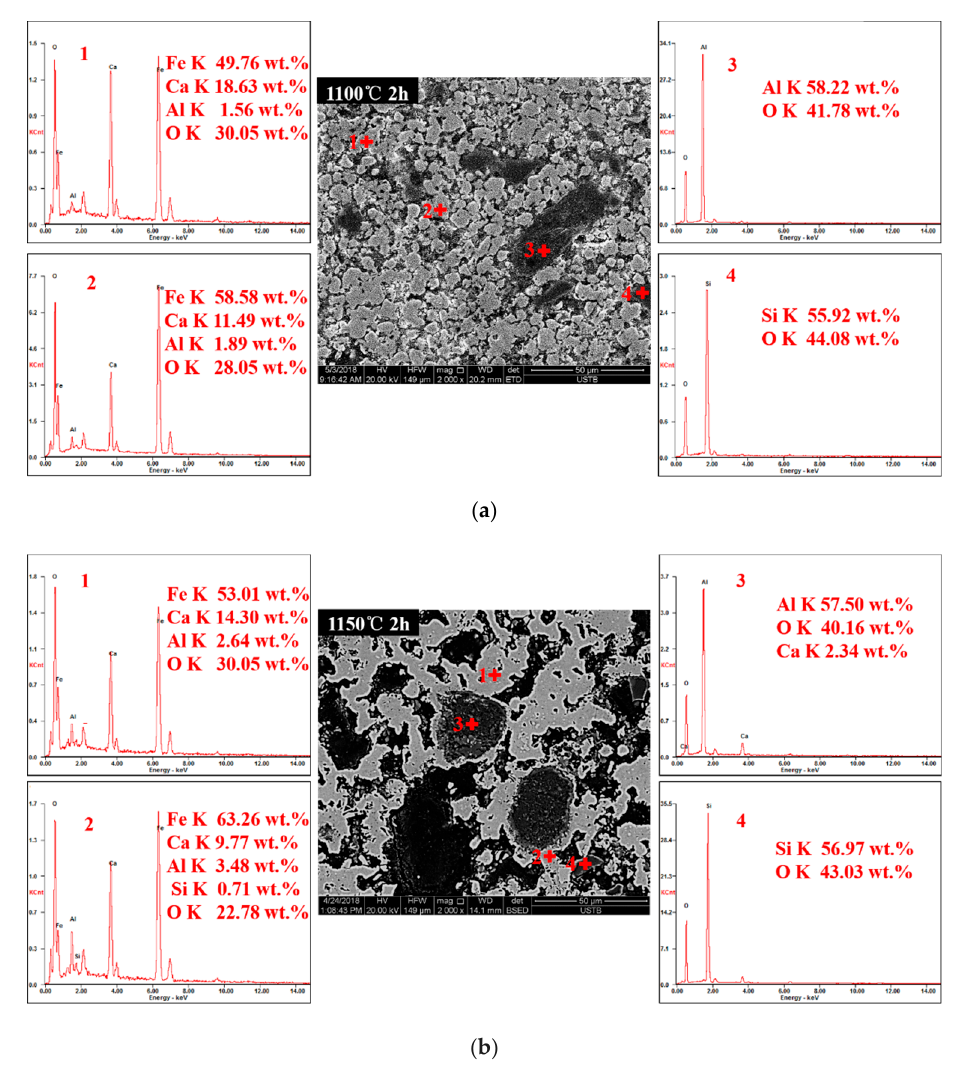
Figure 7. The SEM and EDS results of the quenched sample C sintered at ( a ) 1100°C and ( b ) 1150°C for 2 h.